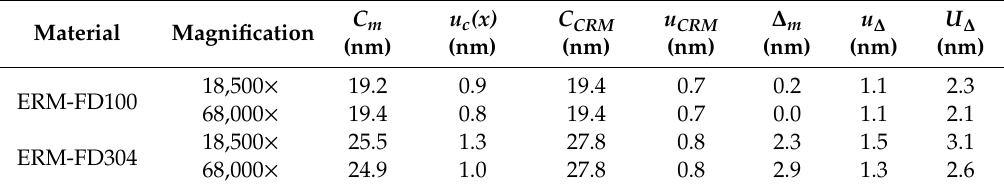
Table 3. Summary of statistical parameters needed to assess the trueness of the approach, based on measurement of the modal equivalent circular diameter (ECD) of ERM-FD100 and ERM-FD304 at magnifications of 18,500 × and 68,000 ×